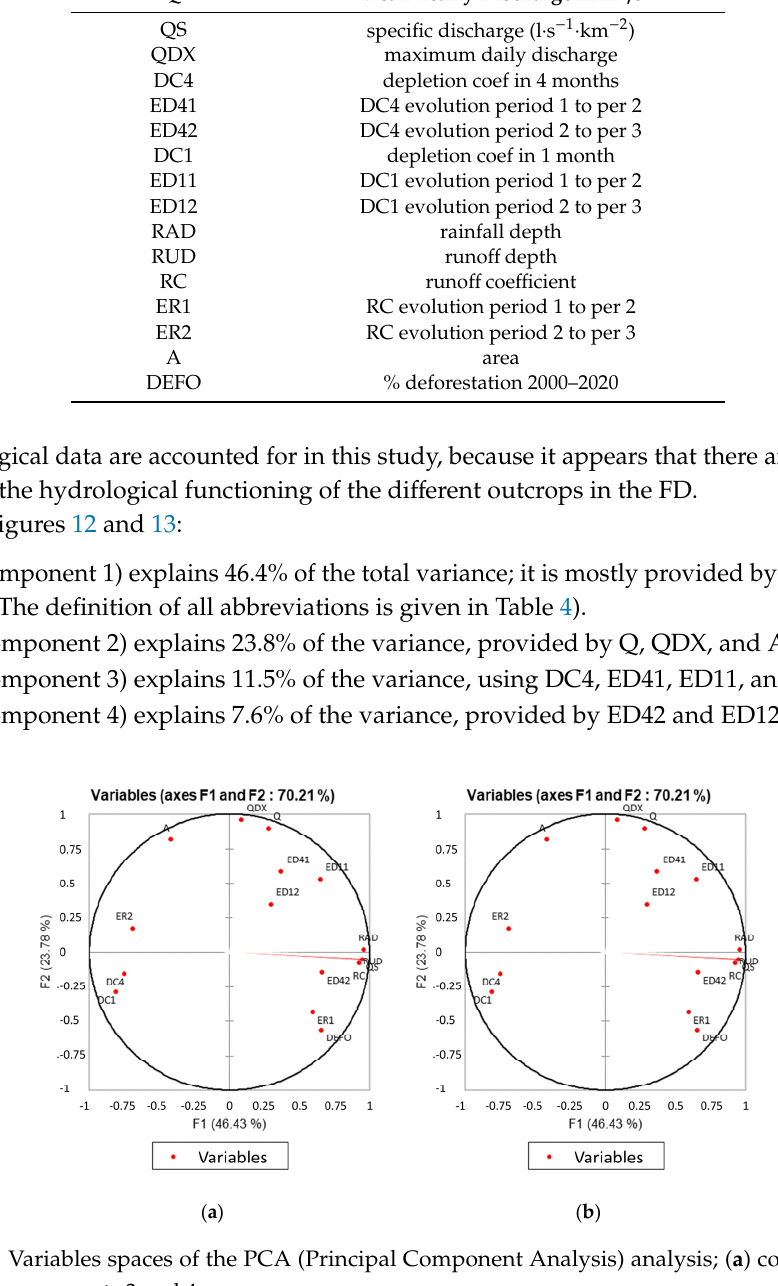
Table 4. List of the variables considered in the PCA analysis.